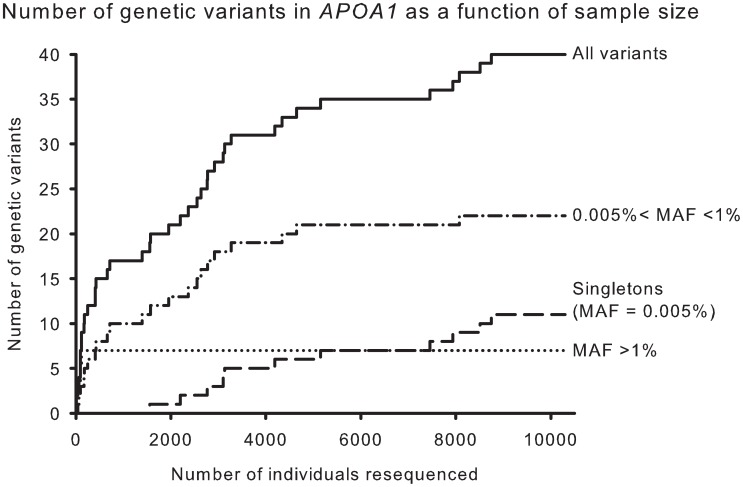
Cumulative number of genetic variants in APOA1 as a function of number of individuals resequenced.Results are shown for all variants (solid) and for variants stratified by minor allele frequencies (MAFs), >1% (dotted), 0.005<MAF<1% (dash-dot), and MAF = 0.005% (long dash).